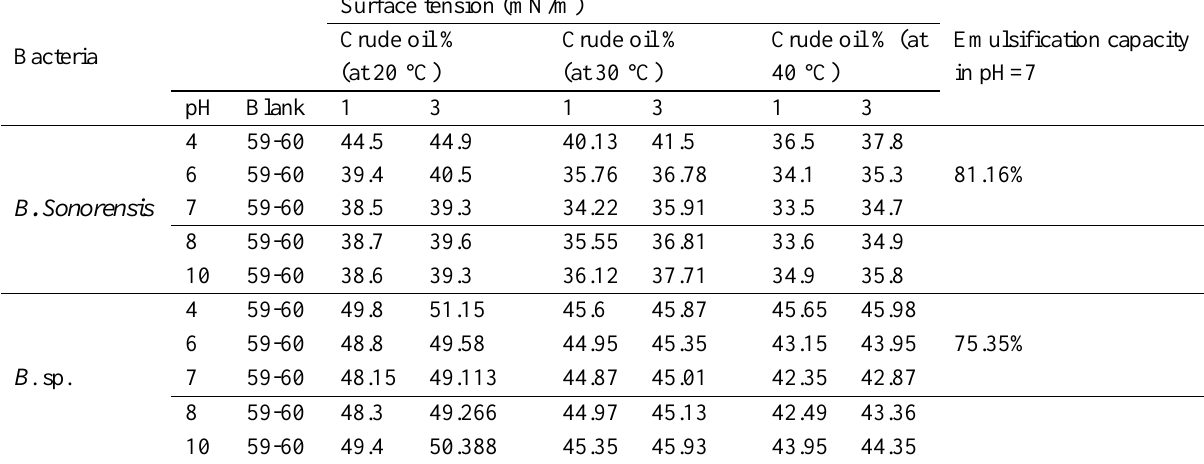
Table 1. The amount of B . Sonorensis and B . sp. surface tensions (temperature: 20, 30, 40 °C; C: 1, 3%; time: 48 h)